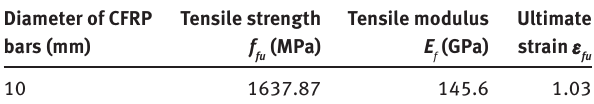
Table 3: The material properties of CFRP bars. Diameter of CFRP Tensile strength bars (mm)